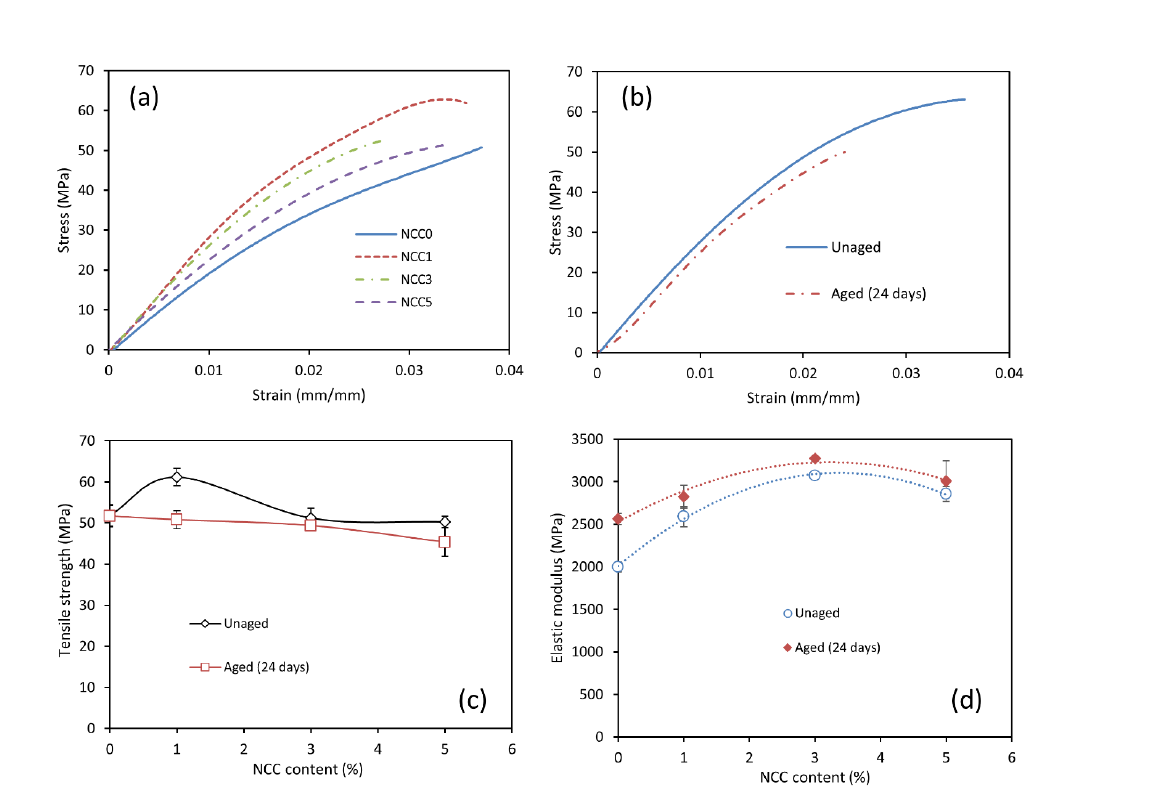
Fig. 3. Showing (a) typical of stress-strain curves of NCC/UPR composites at various NCC content, (b) stress-strain curves of unaged and aged condition of 1 wt% NCC, (c) the tensile strength, and (d) the elastic